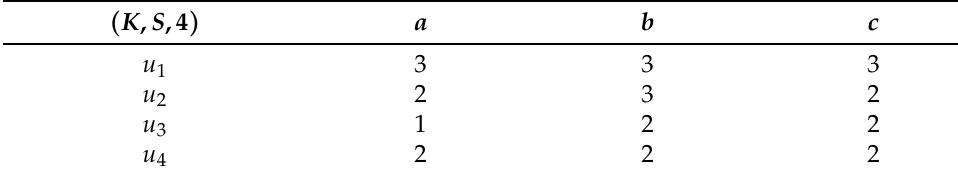
Table 7. The 4-Soft Set of ( K , S ,4 ) . ( K , S , 4 ) a b c u 1 3 3 3 u 2 2 3 2 u 3 1 2 2 u 4 2 2 2 Since, K ( bc )( u 3 ) (cid:54)≥ min { K ( b )( u 3 ) , K ( c )( u 3 ) } .